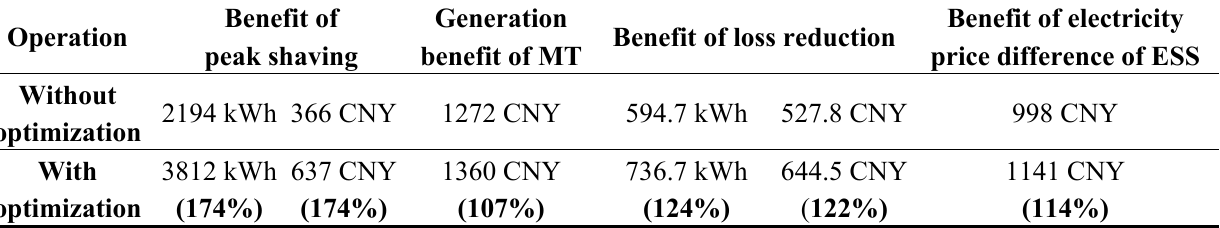
Table 2. Comparison of economic benefits with/without the optimization.